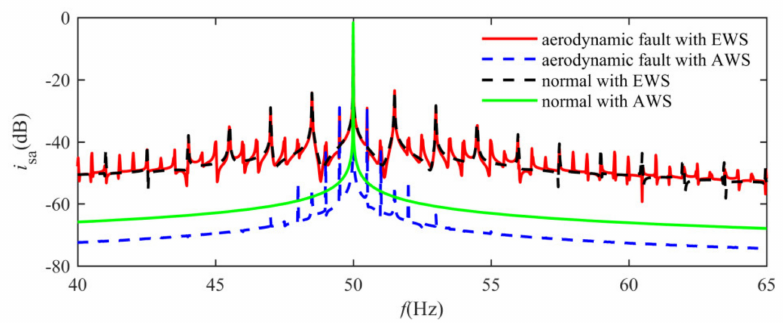
Figure 9. Stator current comparison under the aerodynamic